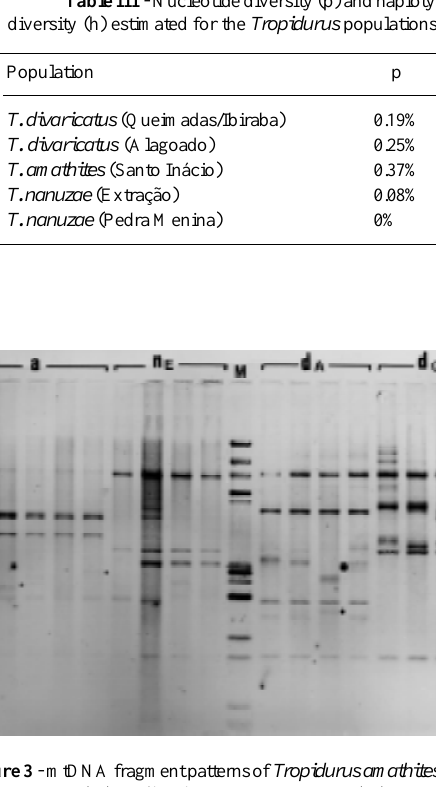
), Queimadas (d ), and A Q